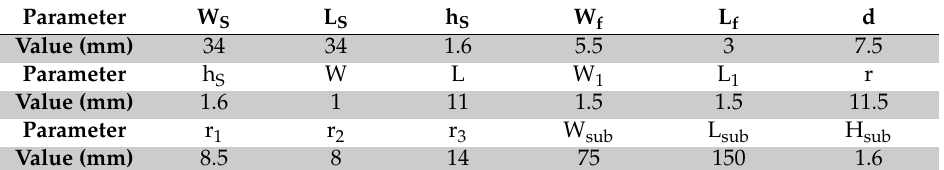
Figure 1. Overall view of the single ‐ element Ultra ‐ Wideband (UWB) antenna design, ( a ) three ‐ Figure1. Overallviewofthesingle-elementUltra-Wideband(UWB)antennadesign,( a )three-dimensional dimensional (3D) view, ( b ) top, and ( c ) bottom layers. (3D) view, ( b ) top, and ( c ) bottom layers. Table 1. Parameter values of the proposed UWB diversity Table 1. Parameter values of the proposed UWB diversity designs.